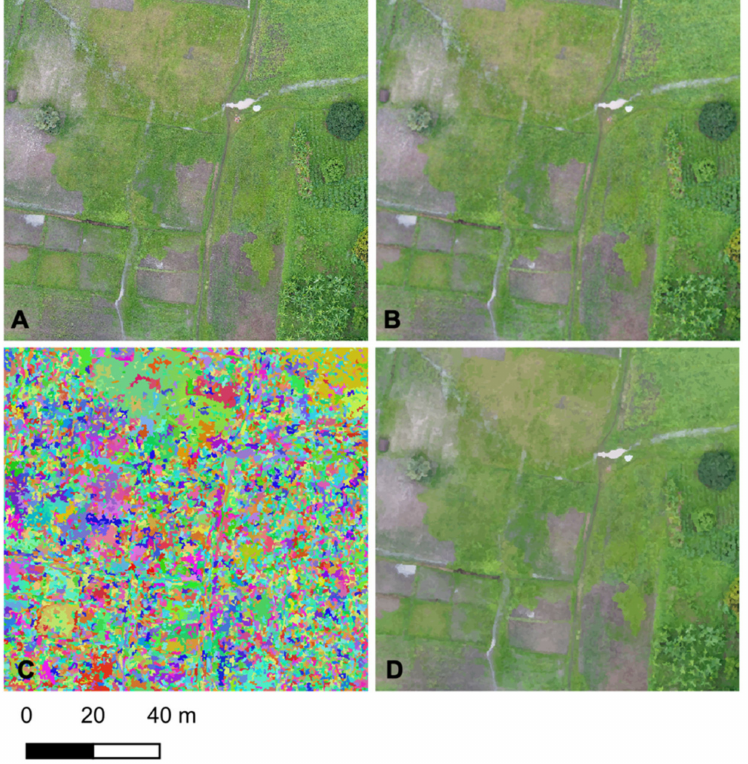
Figure 2. Example image processing workflow from ( A ) the original 20 cm drone orthomosaic; ( B ) 3 × 3 median filtered image; ( C ) segmented objects; ( D ) population of RAT with image statistics, here illustrated by mean red, green, blue